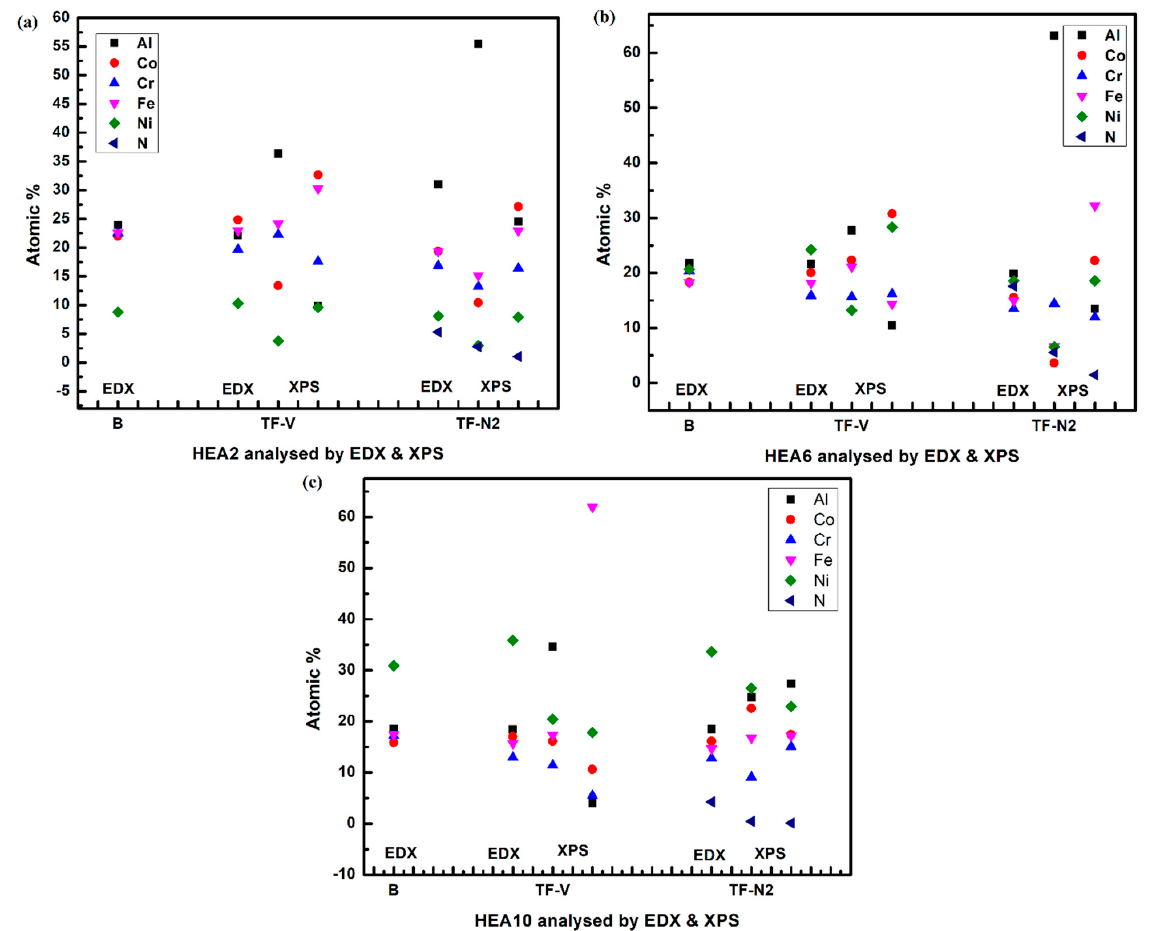
Figure 7. Plotted data on chemical elemental composition measurements by EDX and XPS of HEAs bulk SS, and corresponding thin HEAs as well as HENs films of nickel concentration of ( a ) 0.4, ( b ) 1.2, and ( c )